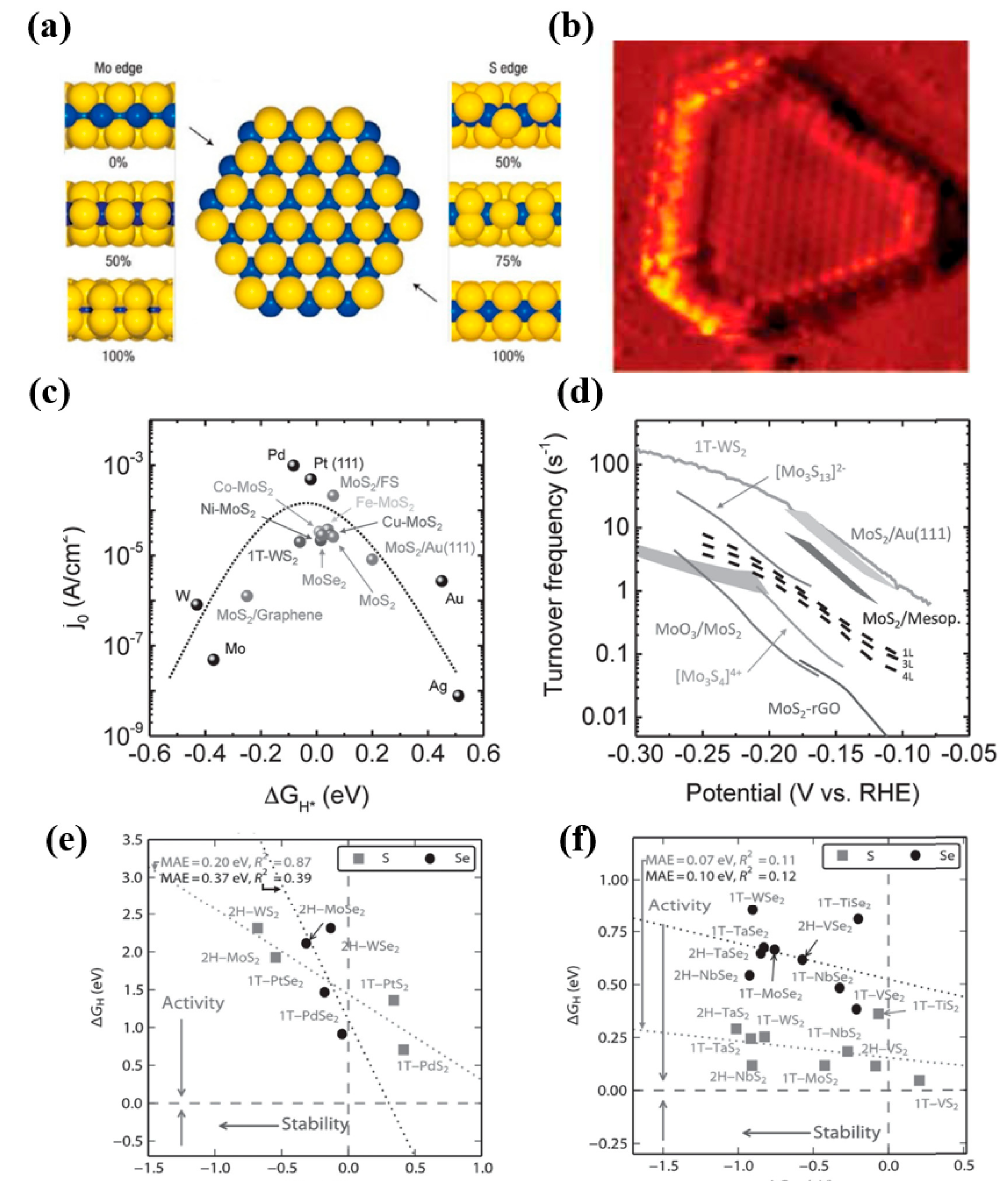
Figure 3. ( a ) Molecular model of a platelet exposing both Mo and S-edges from top and side view. Reprinted with permission from [79], copyright (2014), American Chemical Society. ( b ) STM on MoS 2 nanoplatelets on Au (111). Reprinted with permission from Reference [77], copyright (2007), American Association for the Advancement of Science. Thermodynamics of hydrogen adsorption on 2D transition metal dichalcogenides. ( c ) Sabatier “volcano” plot showing the exchange current density as a function of free energy of hydrogen adsorption of free-standing (FS) MoS 2 edges, MoS 2 edges on Au (111), MoS 2 edges on graphene, vertically grown Fe, Cu, Ni, Co-promoted MoS 2 edges, vertically grown MoS 2 edges, vertically grown MoSe 2 edges, 1T WS 2 basal plane and compared with various metals. ( d ) Evolution of turnover frequency of several catalysts based on transition-metal chalcogenides with overpotential. ( e , f ) Plots of Δ G H *: the free energy of hydrogen adsorption as function of Δ G HX (X = S or Se): the HX adsorption free energy. ( e , f ) The evolution is displayed for metallic TMDs ( e ) and semiconducting TMDs ( f ). In general the stronger binding of X ( Δ G HX < 0), the higher stability of TMDs, the lower the reactivity of TMDs ( Δ G H * > 0), the weaker the hydrogen binding. Reprinted with permission from Reference [23], copyright (2016), Wiley-VCH.